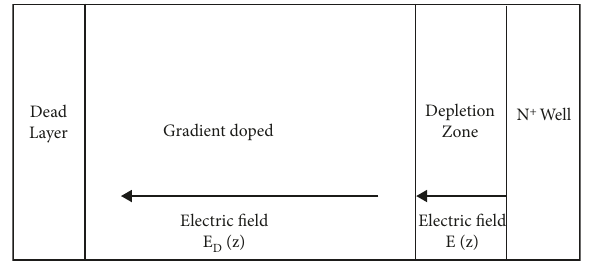
Figure 3: Electric field distribution model for exponential doping of electron multiplication